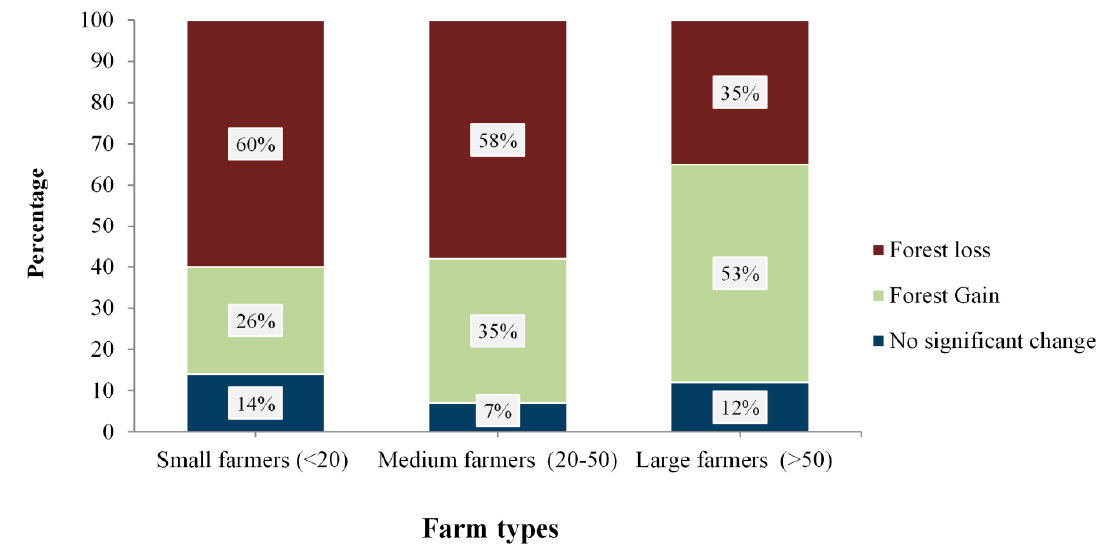
Figure 8. Main uses of forest related products based on farm type.